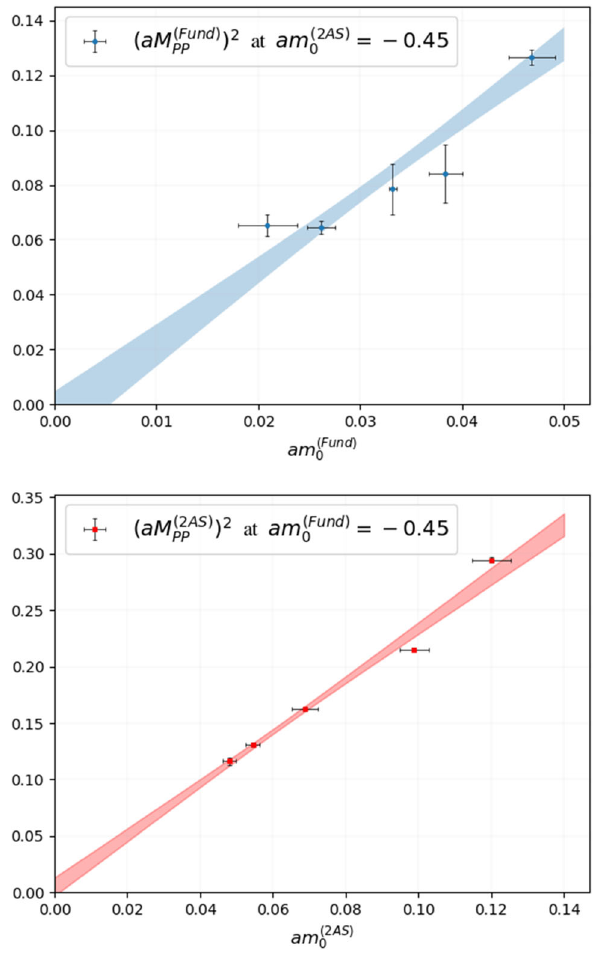
Fig. 6 Scaling predicted by the Gell-Man–Oakes–Renner relation, with the squared mass of the pseudoscalar Goldstone boson scaling lin- early with the quark mass, here estimated from the PCAC relation. The extrapolation is compatible with the Goldstone bosons becoming mass- less at the chiral point. In the top panel, the fit has χ 2 / d . o . f . = 1 . 68 , while in the bottom panel χ 2 / d . o . f . = 1 .